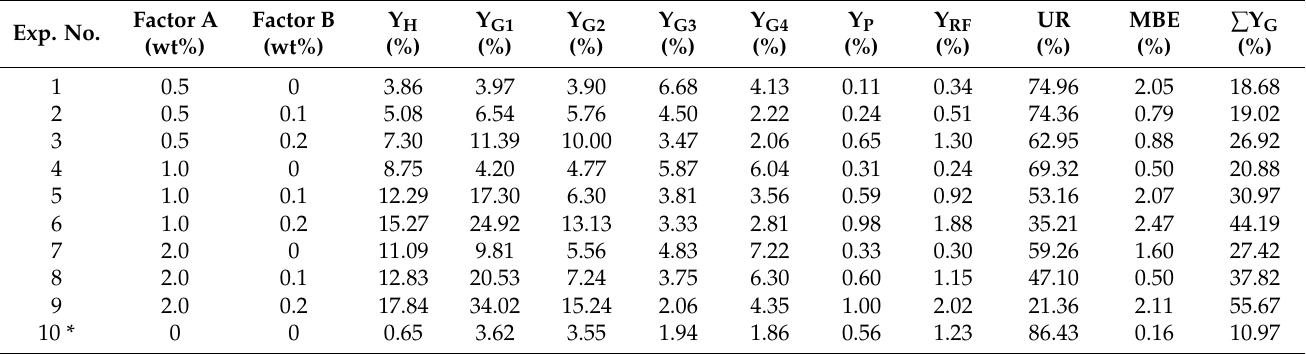
Table 1. The experimental design and the results of process mass